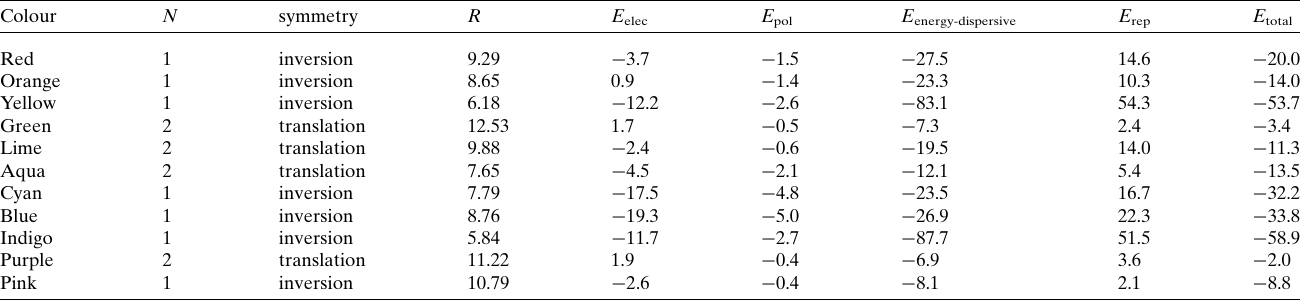
Table 3 Interaction energies (kJ mol (cid:5) 1 ) between a reference molecule and its neighbours. N is the number of equivalent neighbours, R is the distance between molecular centroids (mean atomic position) in A˚ . The colours identify molecules in Fig. 5 a , with the reference molecule shown in grey. Colour N symmetry R E elec